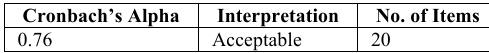
Table 6. Reliability